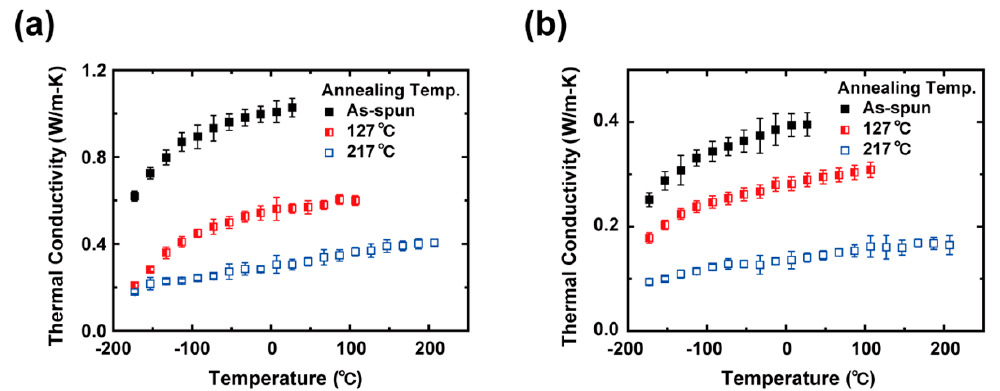
Figure 7. Thermal conductivities of as-spun, T g -annealed, and crosslinked PAA NFs, which were electrospun at ( a ) 14 kV and ( b ) 20 kV, respectively, as a function of temperature. The thermal conductivities monotonically increased with temperature due to the chain-stretching e ff ect. Annealing at T g (127 ◦ C) increased the mobility of the molecular chains, i.e., the rubbery state, resulting in the conformational change and decrease in thermal conductivity of NFs. After crosslinking at 217 ◦ C, further reduction of k was observed because of an increase in the quantitative proportion of gauche